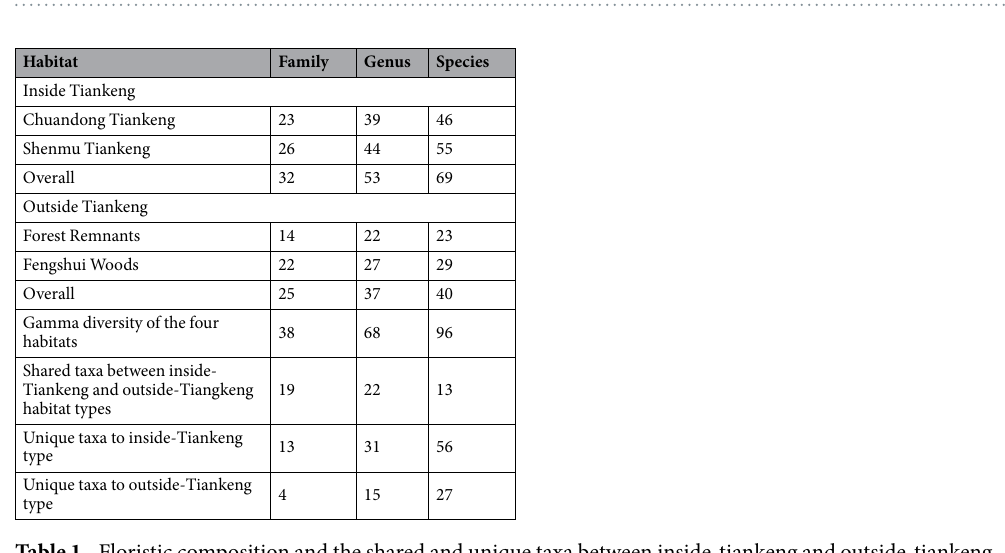
Figure 3. Rank abundance curves by family, showing number of families across habitats and the abundance and evenness patterns.